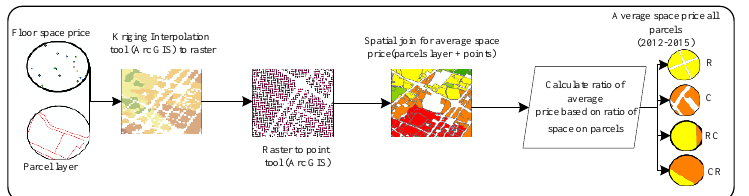
Figure 2. The process of estimating average floor-space price .